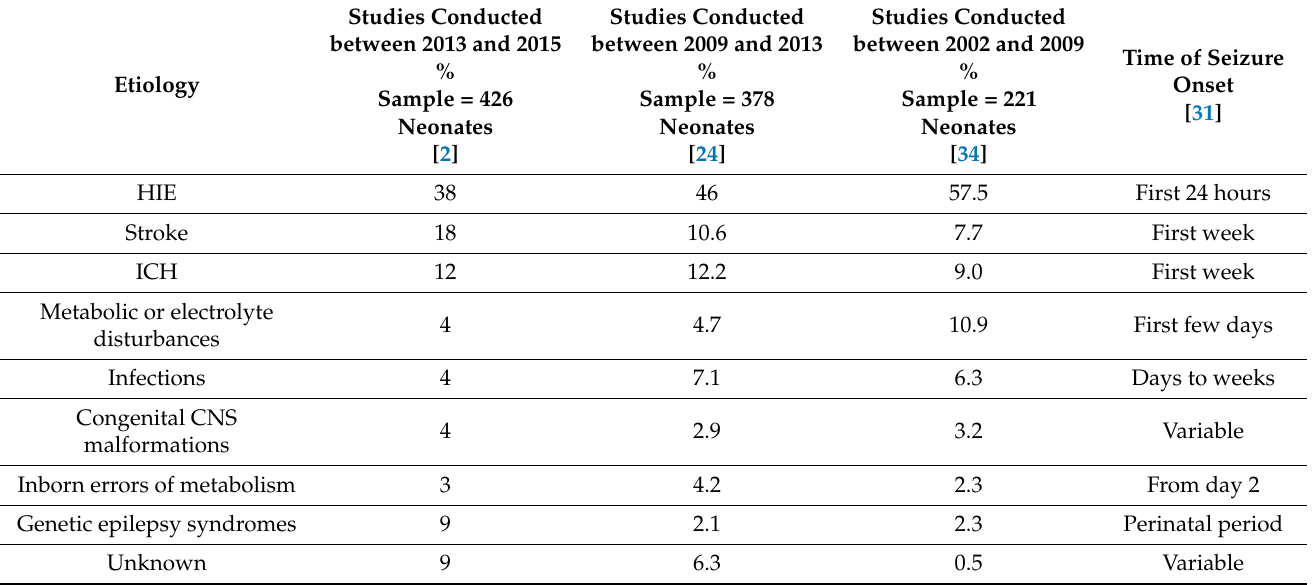
Table 1. Etiology and onset of neonatal seizures.